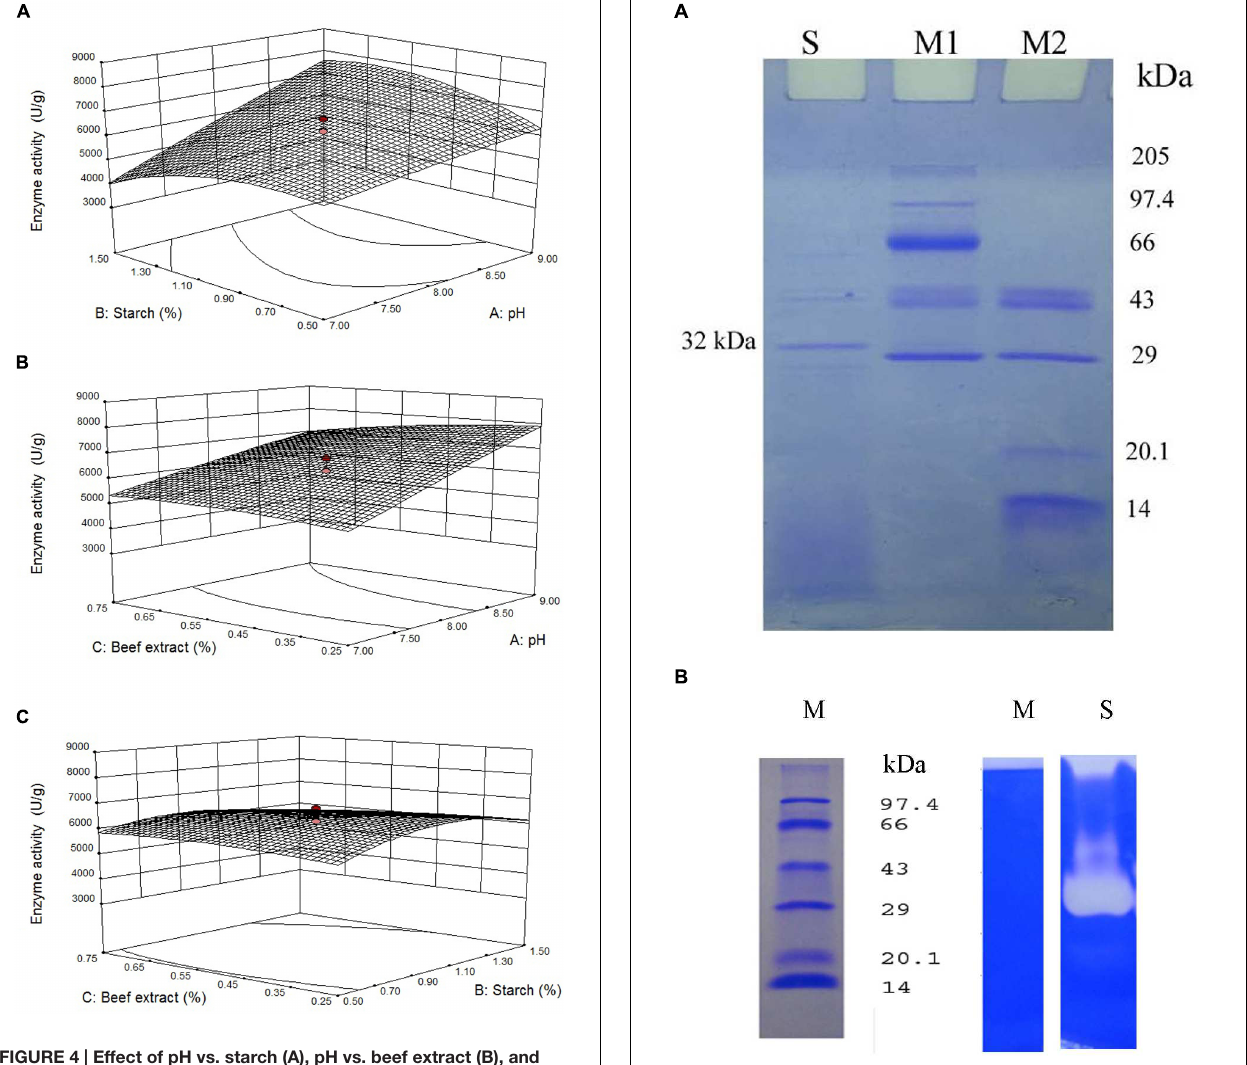
IND7 (S- Crude fibrinolytic enzyme; M1-Protein marker [205 kDa – 29 kDa]; M2 – Protein marker [43 kDa-14 kDa]). (B) Zymogram analysis of the crude enzyme on 12% (w/v) sodium dodecyl sulfate – polyacrylamide slab gel (M, Protein marker; S, Crude fibrinolytic enzyme). Two ranges of protein markers (205 kDa – 29 kDa and 43 kDa – 14 kDa) were applied to determine the molecular weight of